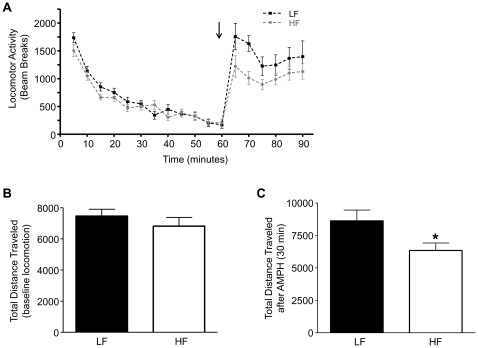
AMPH-induced locomotor activity is reduced in HF DIO rats.Locomotor activity was assessed in HF and LF rats before and after an i.p. injection of AMPH (1.78 mg/kg). (A) Locomotor activity measured by beam breaks over time. Each data point represents 5 minutes of recording bins. The arrow indicates administration of AMPH at 60 minutes. (B) Total distance traveled by HF and LF rats measured during the first 60 minutes (before AMPH; p≥0.05 by Student's t-test, n = 12). (C) Total distance traveled measured in HF and LF rats in a 30 min time period after AMPH injection (*p<0.05 by Students t-test, n = 12). Data are represented as mean ± S.E.M.